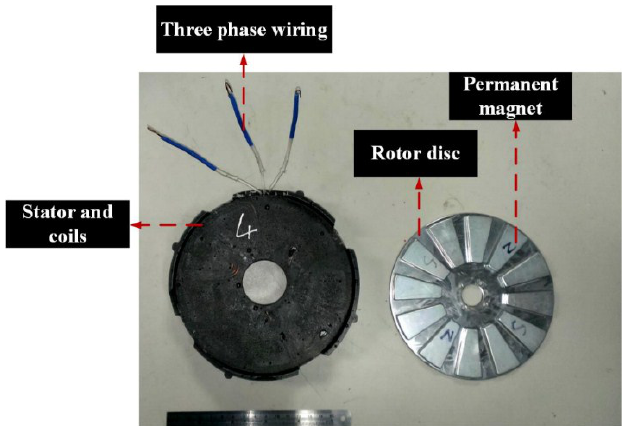
Figure 3. The stator and rotor of the AFPM